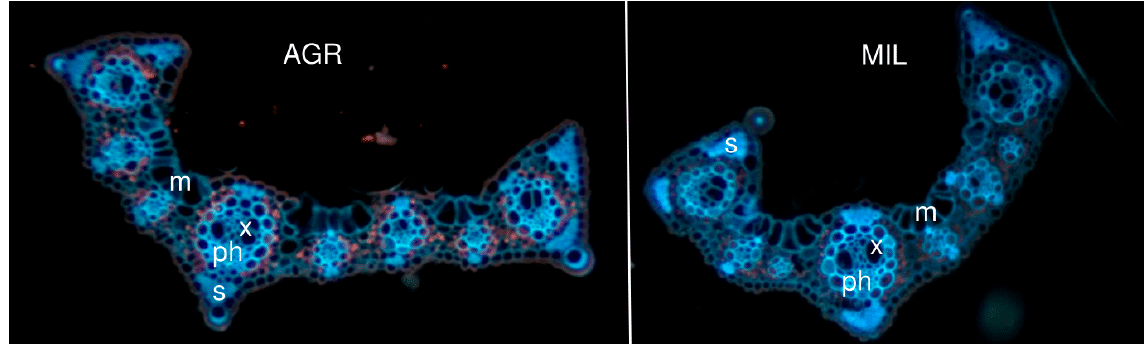
Figure 4. Leaf section (1 cm from tip), m: motor cell, x: xylem, ph: phloem, s: sclerenchyma area